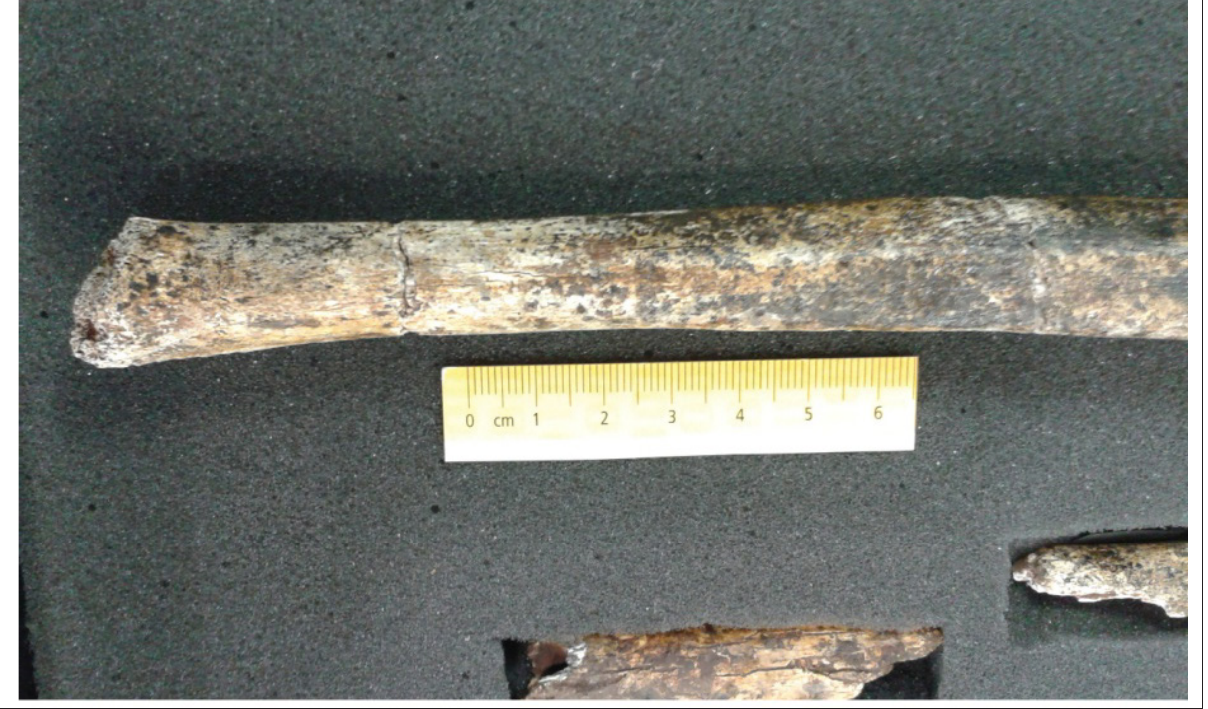
Figure 6: Tibia shaft specimen UW 101-1070, H. naledi from the Dinaledi Chamber, with dotted coatings of manganese oxy-hydroxide. It is suggested that the black dots result, at least in part, from the growth of lichen as a bacterial–algal–fungal symbiont that includes a photobiont. The growth of lichen on such bone surfaces, even for a limited time, may have occurred in subdued but essential lighting. Note the distribution of manganese oxy-hydroxide, extending from a continuous mat to more dotted occurrences; this pattern is potentially analogous to the dispersal of lichen from a central thallus. Photograph: F Thackeray (University of the